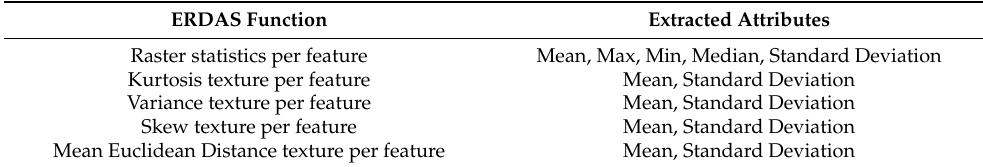
Table 2. Extracted attributes per